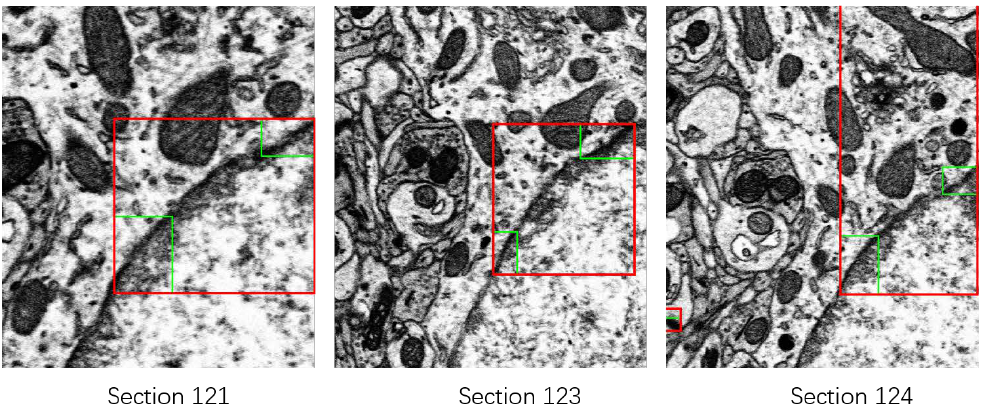
Figure 16. Misidentified MSBs on three adjacent